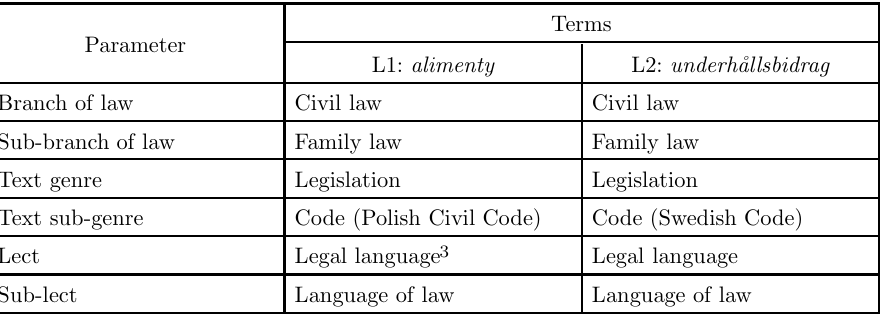
Parametric characteristics of the terms alimenty and underh˚allsbidrag